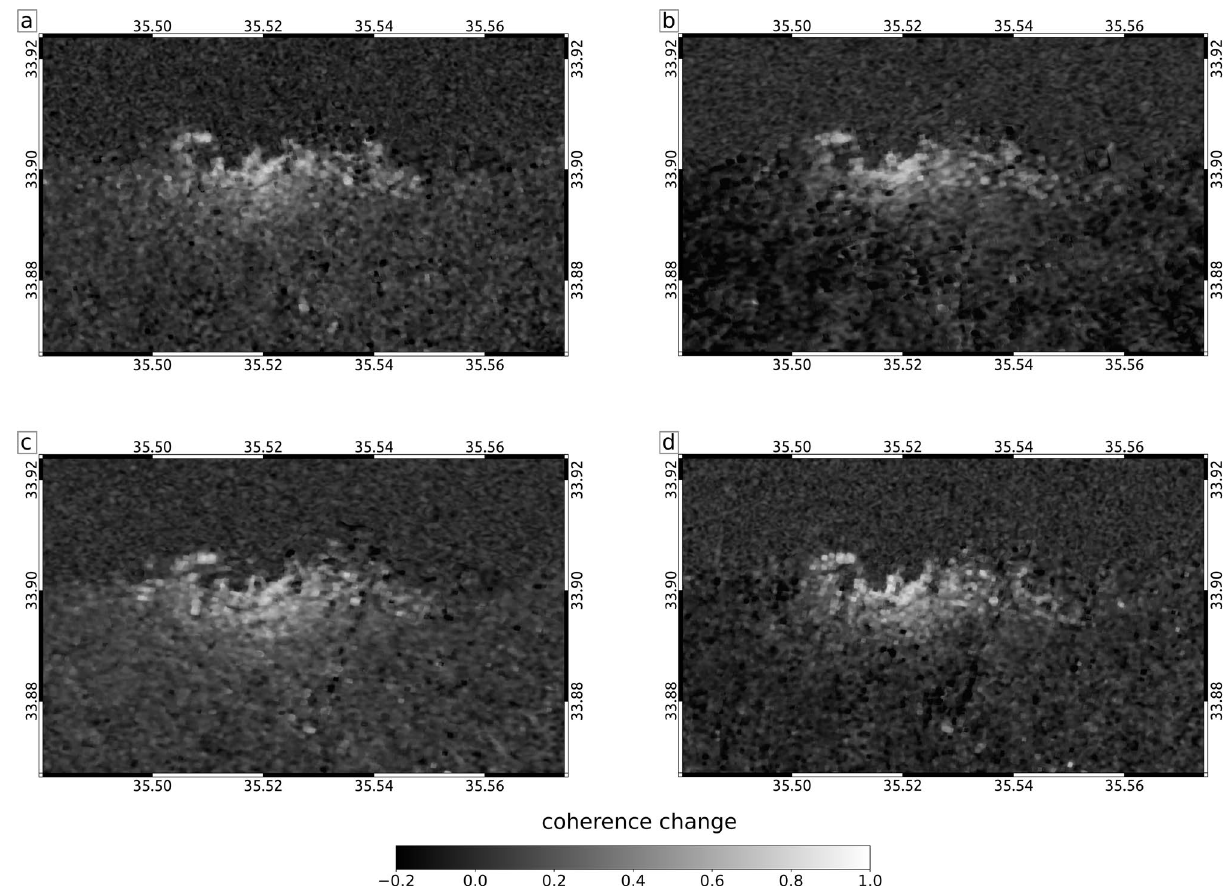
Figure 6. Sentinel-1 coherence change detection results for relative orbit 87 ( a ), 14 ( b ), 95 ( c ) and 21 ( d